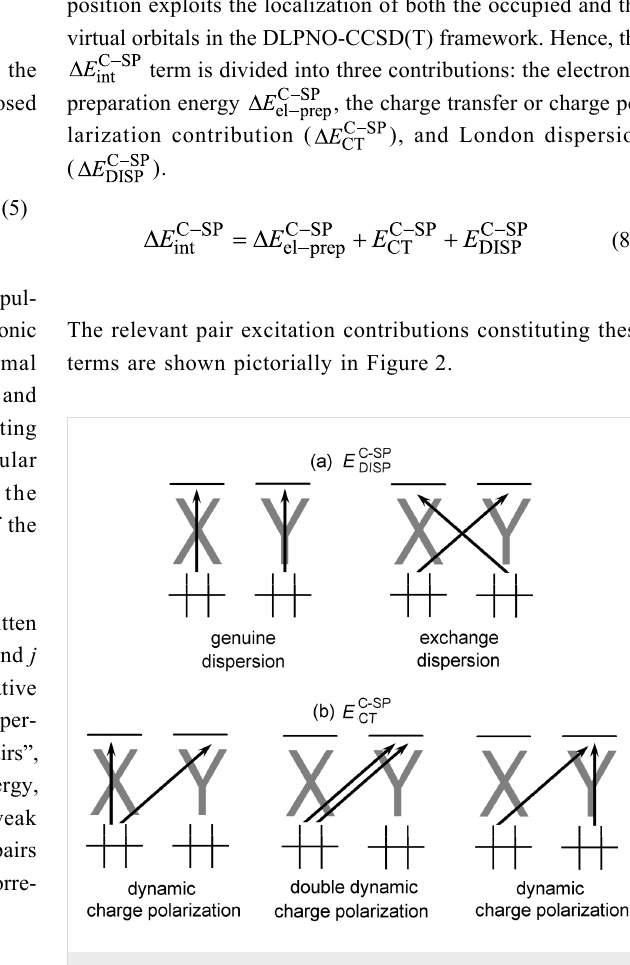
Figure 2: Schematic representation of strong pair excitations in the framework of the DLPNO-CCSD(T) method. Electronic preparation arises from excitations occurring within the same fragment, which are not shown. Only the charge transfer excitations from X to Y are shown. Analogous charge transfer excitations also exist from Y to X